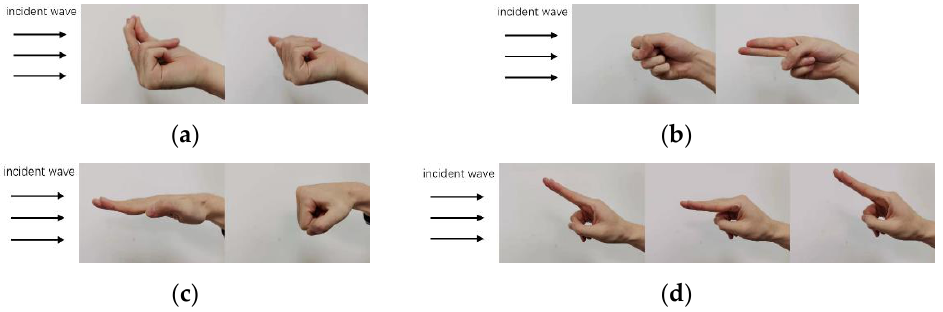
Figure 6. Illustrations of four different dynamic hand gestures: ( a ) snapping fingers, ( b ) flipping fingers, ( c ) clenching hand, ( d ) clicking fingers.